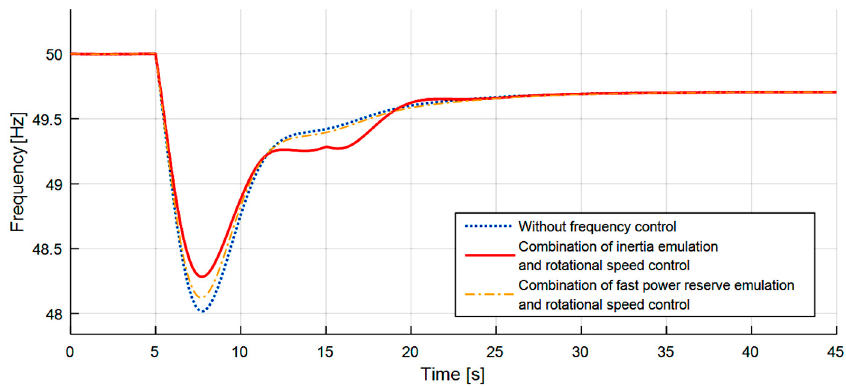
Figure 17. Frequency response for different controllers in Low wind speed case after frequency